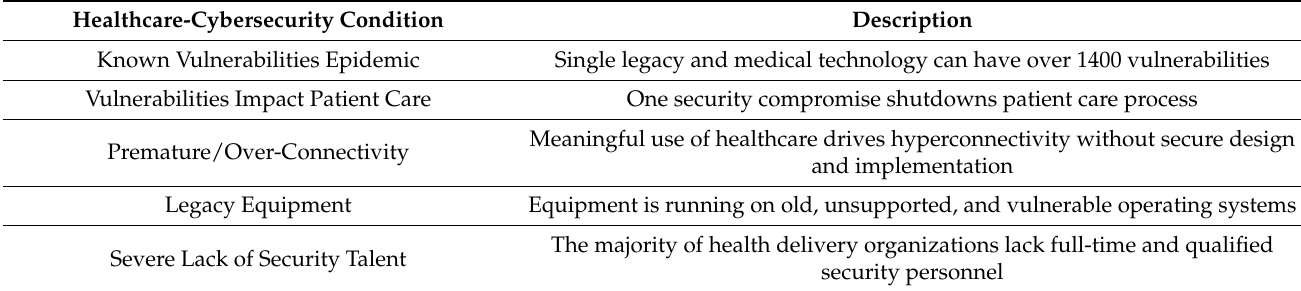
Table 7. Status of healthcare system based on vulnerabilities